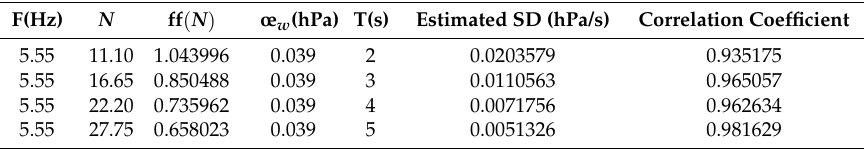
Table 5. PCR probability distribution model estimation and correlation coefficient.